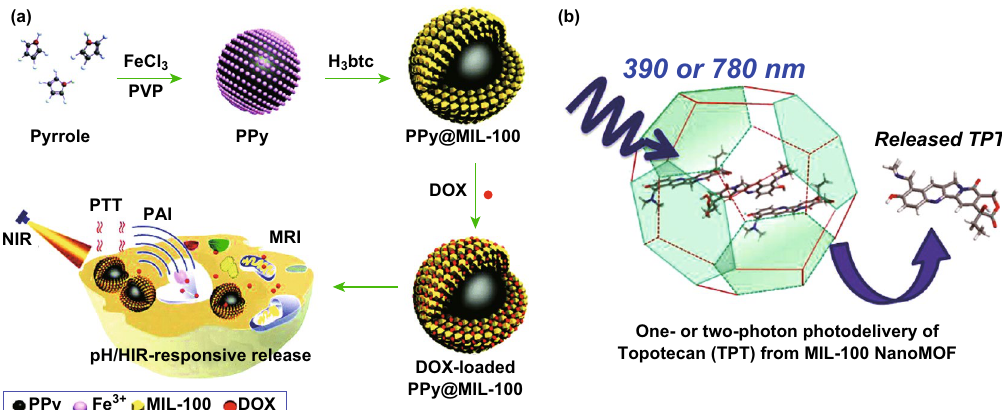
Fig. 9 a Schematic illustration of the synthesis of PPy@MIL-100(Fe) as a pH/NIR-responsive drug carrier for dual-mode imaging and synergis- tic chemo-photothermal therapy. Reproduced with permission from Ref. [36]. Copyright 2017, The Royal Society of Chemistry. b MIL-100(Fe) NMOF for one- or two-photon-induced photodelivery of topotecan. Reproduced with permission from Ref. [39]. Copyright 2013, American Chemical